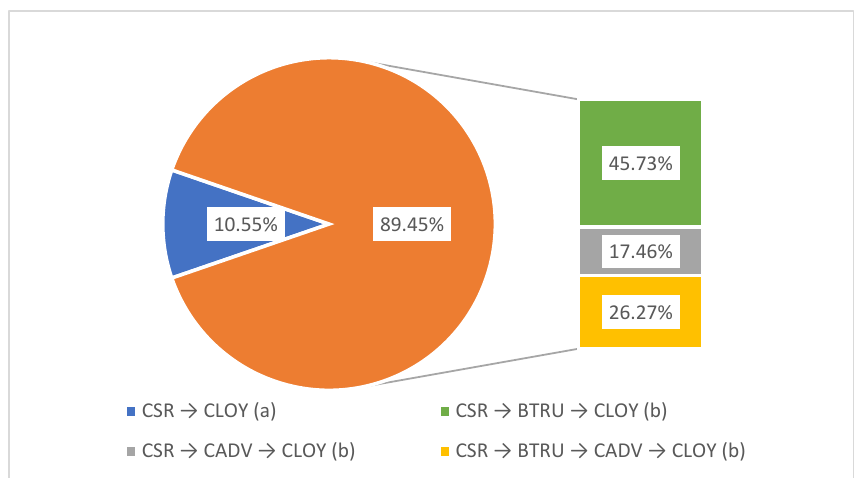
Figure 5. VAF the direct and indirect effects of perceived CSR on customer loyalty. Note: (a) = VAF the direct effect; (b) = VAF the specific indirect effect.